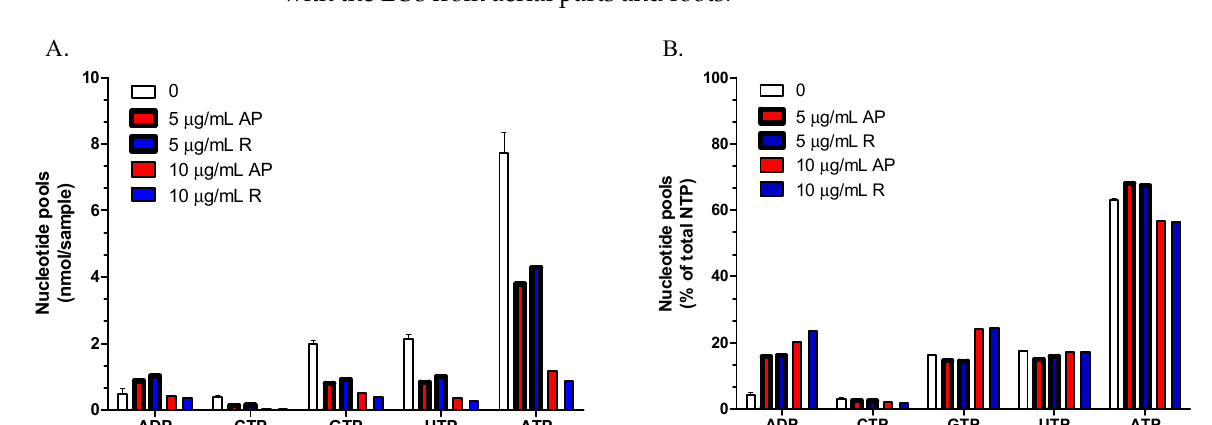
Figure 5. Effect of A. nemorosa EOs on T. brucei nucleotide pools. ( A ). Levels in nmol per sample of nucleoside triphosphates (NTPs) and ADP when T. brucei cells are treated with different concentrations of EOs from A. nemorosa aerial parts (AP) and roots (R); ( B ). Same data as in A, but the nucleotides are replotted as a percentage of the total NTP pool.